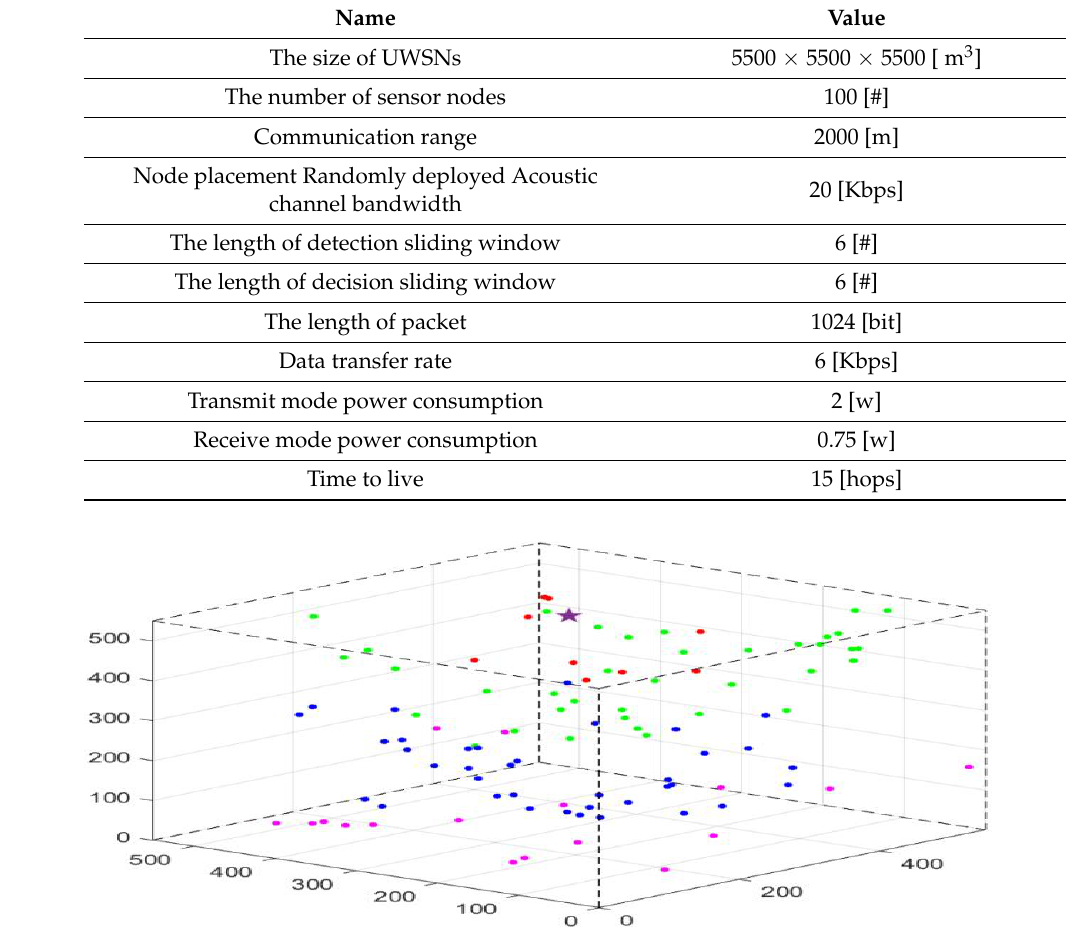
Table 2. Simulation parameters.